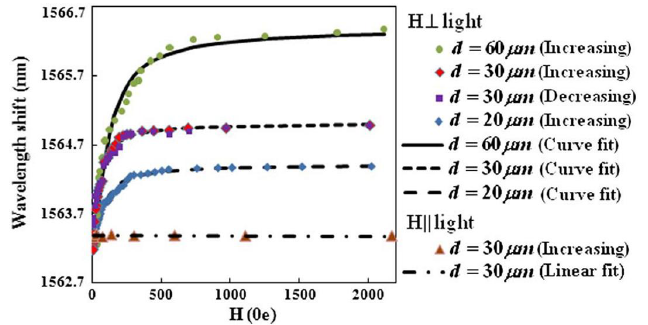
Figure 20. Dependence of the dip wavelength with the magnetic field, for perpendicular and parallel cases. Reproduced from [65], with the permission of OSA.